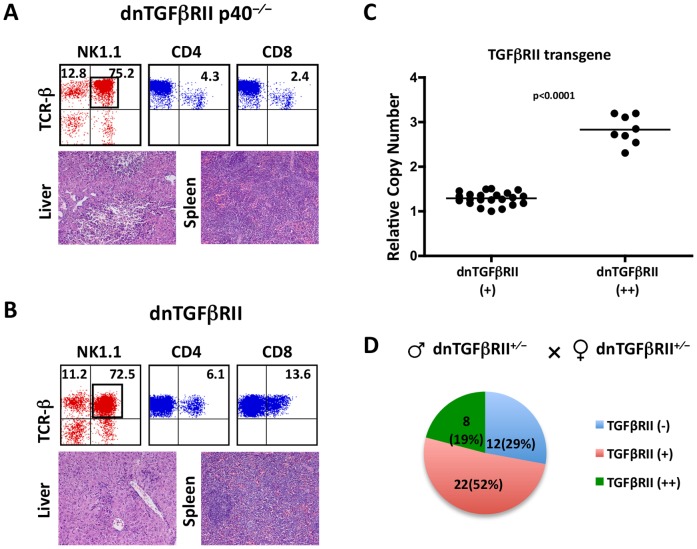
Lymphoma-like T cell infiltrations were only found in homozygous dnTGFβRII p40−/− and dnTGFβRII mice.A. Representative immunophenotype of hepatic lymphocytes (upper panels) and H&E stained sections (lower panels) from inbred dnTGFβRII p40−/− mice with lymphomatous lesions at age of 10 weeks. CD4 and CD8 double negative TCRβ+NK1.1+ cells are predominant in the liver of dnTGFβRII p40−/−. Typical diffuse lymphomatous lesions were found in liver and spleen. B. Representative immunophenotype of liver infiltrating lymphocytes (upper panels) and H&E stained sections from inbred dnTGFβRII mice with lymphomatous lesions at age of 12 weeks. C. Relative copy number of dnTGFβRII transgene detected by real-time PCR. D. The percentage of homozygous and hemizygous offspring from hemizygous TGFβRII parents.